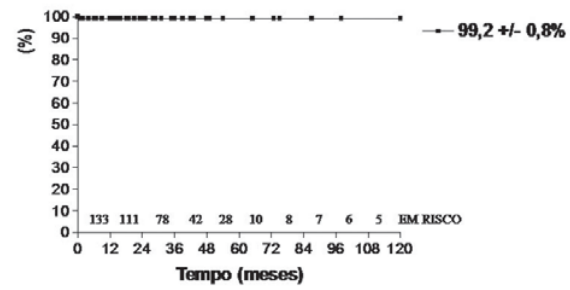
Fig. 4 - Curva atuarial livre de